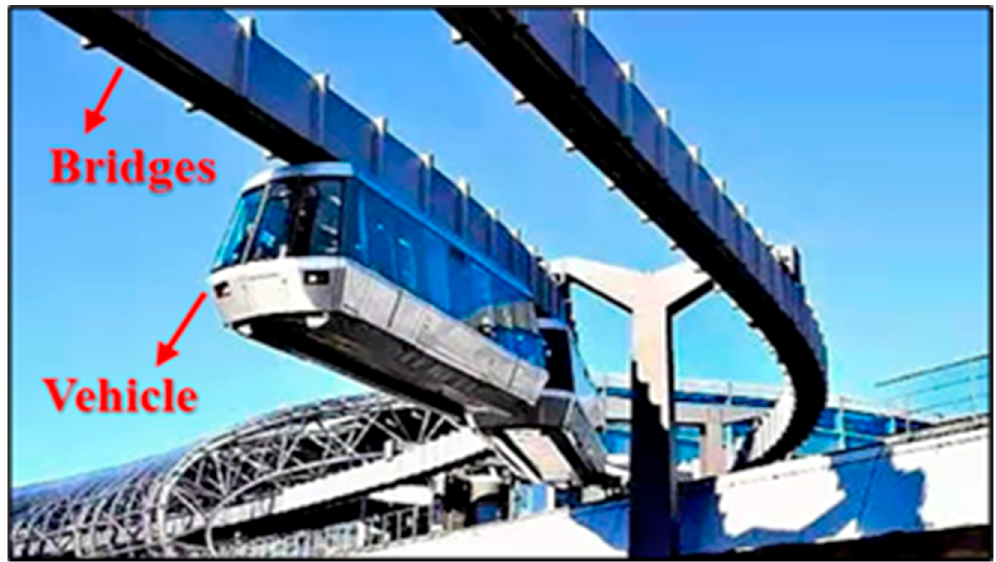
Figure 1. Suspended monorail transit system.